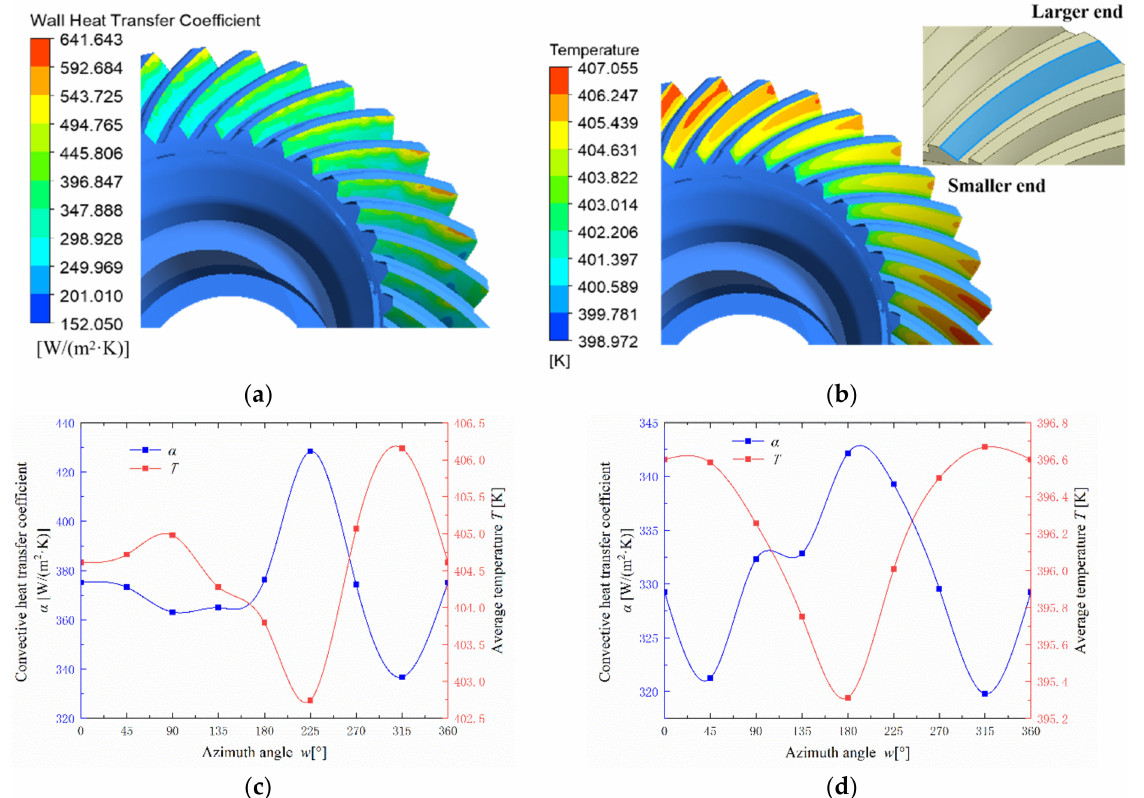
Figure 15. Temperature characteristics of gears: ( a ) convective heat transfer coefficient of driving gear tooth surface; ( b ) temperature of driving gear tooth surface; ( c ) temperature characteristics of driving gear tooth surface; ( d ) temperature characteristics of driven gear tooth